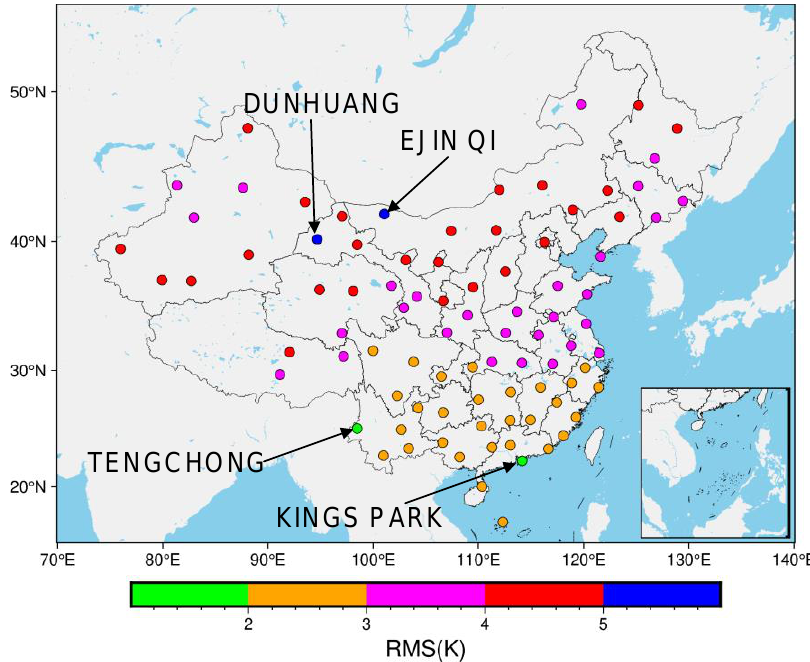
T T linear regression models. Figure 6. Root mean squares of the 88 site-specific T s ∼ T m linear regression models. s m